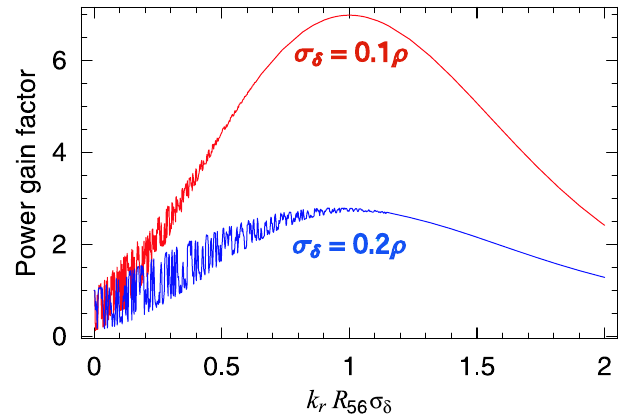
FIG. 1. (Color) 1D power gain factor G with relative energy (cid:1) 0 : 1 (cid:9) (red line) and (cid:10) spread (cid:10) (cid:2)